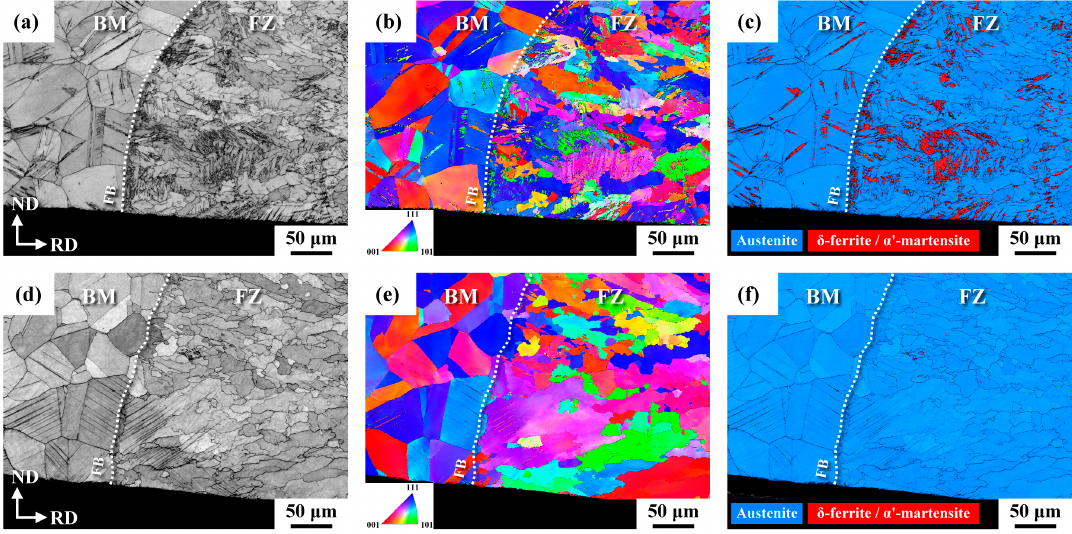
Figure 5. EBSD: ( a ) and ( d ) BC maps, ( b ) and ( e ) IPF maps, ( c ) and ( f ) phase maps of the U-bend samples around FB in cross-sectional view. ( a ), ( b ) and ( c ) the 304 weld; ( d ), ( e ) and ( f ) the 316 weld.